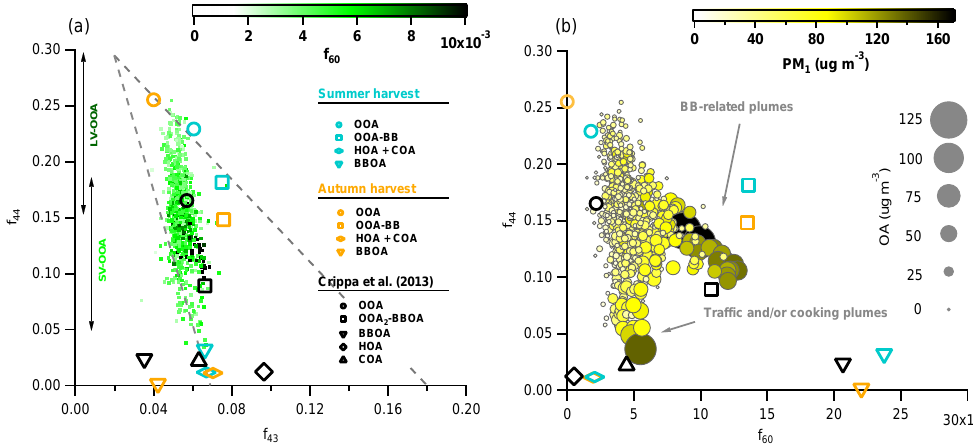
Figure 11. Summary plots showing (a) triangle plot ( f 44 vs. f 43 ) ; SV-OOA and LV-OOA indicate semi-volatile OOA and low volatility OOA, respectively. The dots are colored by f 60 as a biomass-burning marker; (b) f 44 as a function of f 60 ( f 44 vs. f 60 ) , colored by the PM 1 mass concentration and sized by the OA